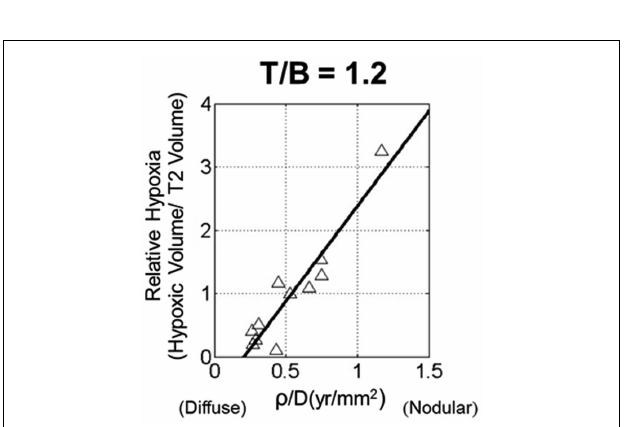
FIGURE 4 | “Example screenshots from glioma growth model simulations with varied points of origin. Images at four time points each for three simulated lesions provided in the sagittal, coronal, and axial planes for lesion start points at the anterior dorsolateral subventricular zone, anterior